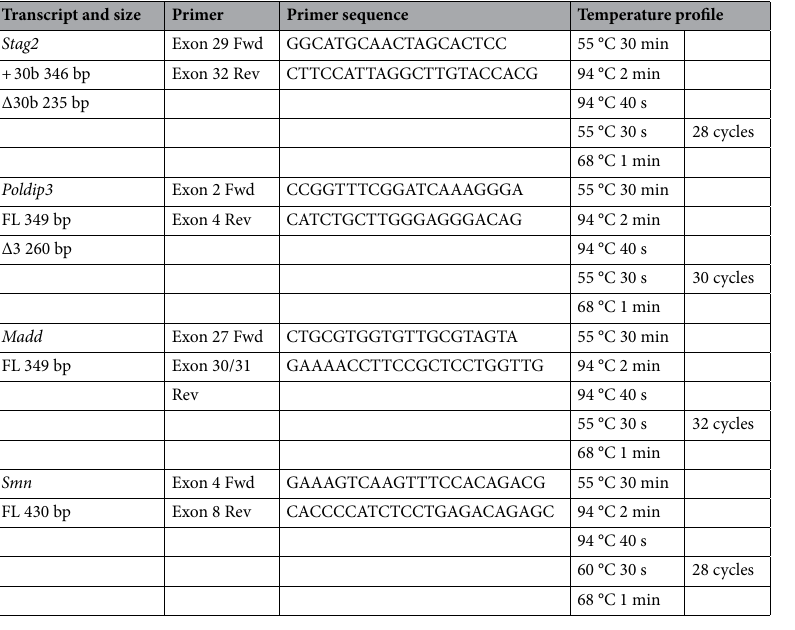
Table 2. Primer sequences and RT-PCR conditions for Stag2 , Poldip3 , Madd and Smn transcript